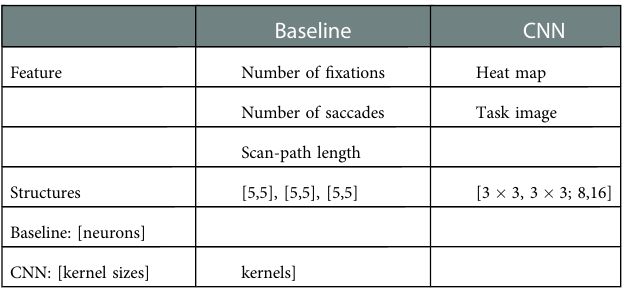
TABLE 5 Details of model structure.